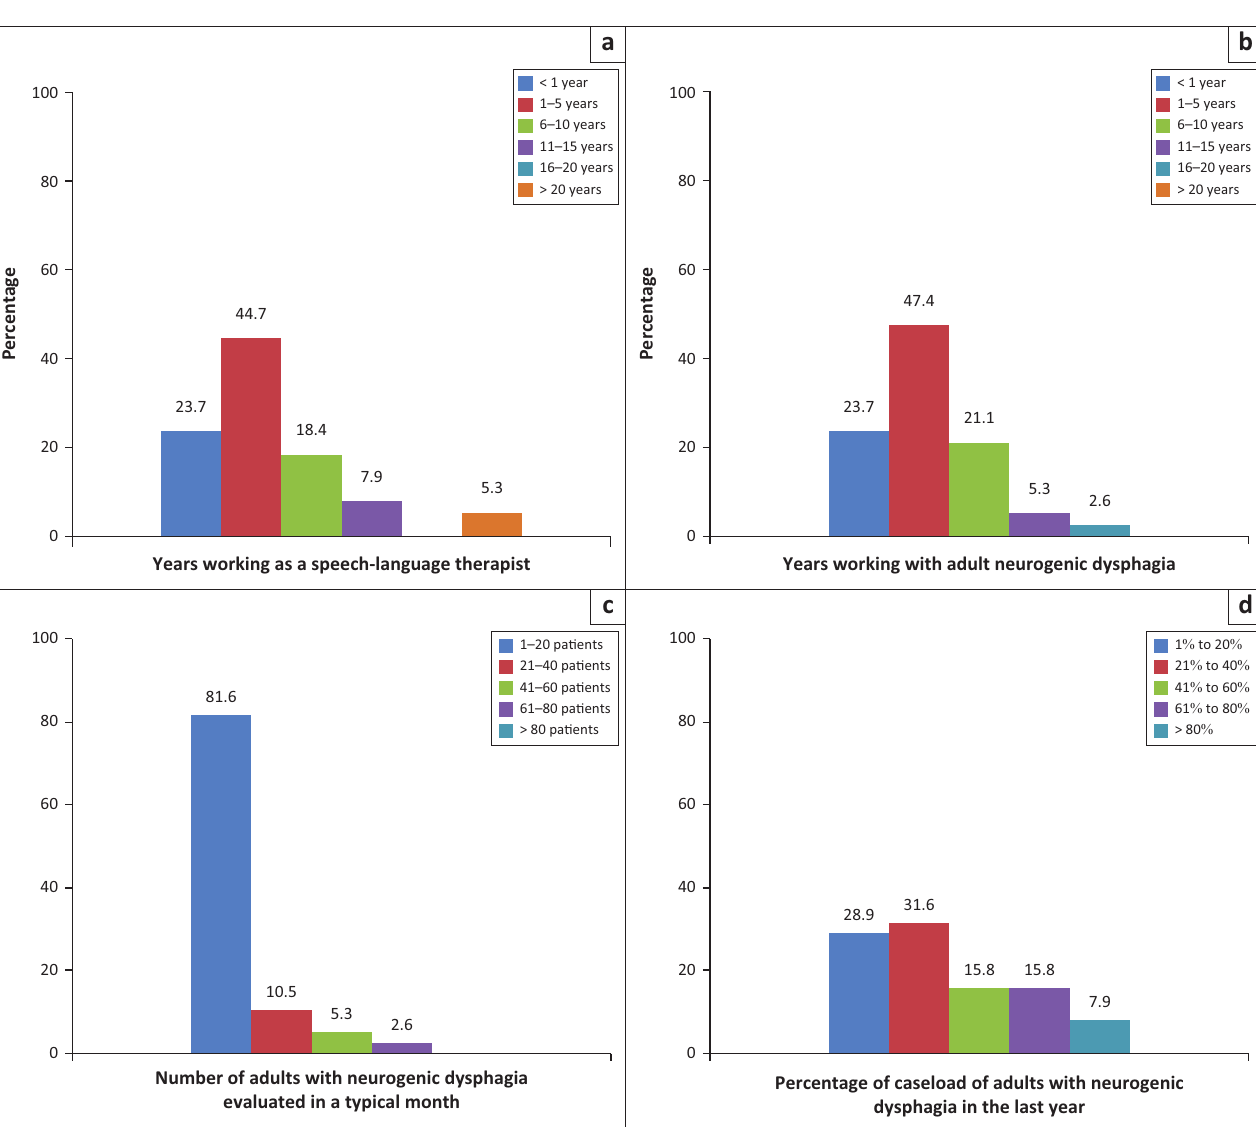
FIGURE 2: Biographical information of participants ( n = 38): (a) Years working as a speech-language therapist; (b) Years working with adult neurogenic dysphagia; (c) Number of adults with neurogenic dysphagia evaluated in a typical month; and (d) Percentage of caseload of adults with neurogenic dysphagia in the last